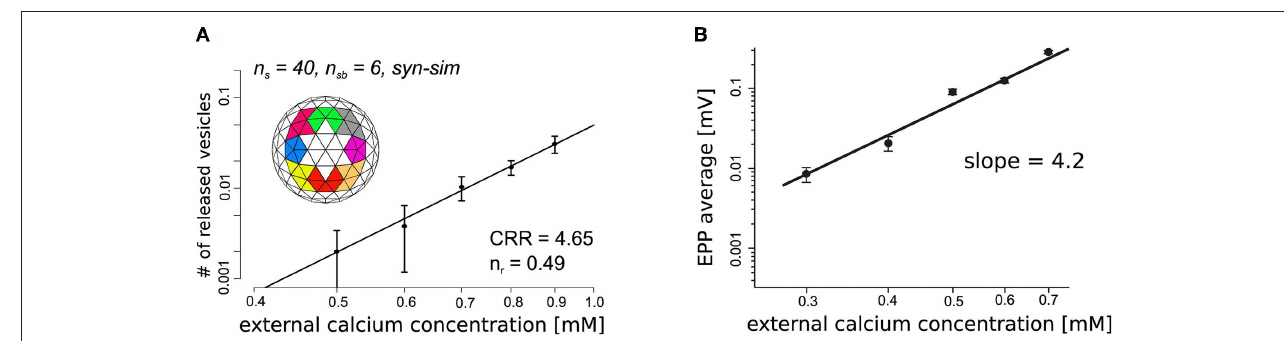
FIGURE 3 | Prediction of fourth order calcium-release relationship using excess calcium ion binding sites with no inherent cooperativity. (A) Plot of predicted vesicle release probability at varying extracellular calcium concentrations using an MCell model with 40 calcium ion binding sites (n s ) per vesicle (inset) but requiring only 6 of these binding sites to be simultaneously occupied (n sb ) to trigger vesicle fusion. The model data display a roughly fourth order relationship (CRR = 4.65) when plotted on a log scale. Under these model conditions, the probability of release per AZ (n r ) was 0.49, closely approximating the experimentally determined value (0.67). (B) Plot of experimental endplate potential amplitude data recorded using microelectrode techniques from a frog nerve-muscle preparation as the concentration of extracellular calcium was varied. When plotted on a log scale, these data display a fourth order relationship (slope = 4.2). Adapted from Dittrich et al. (2013).